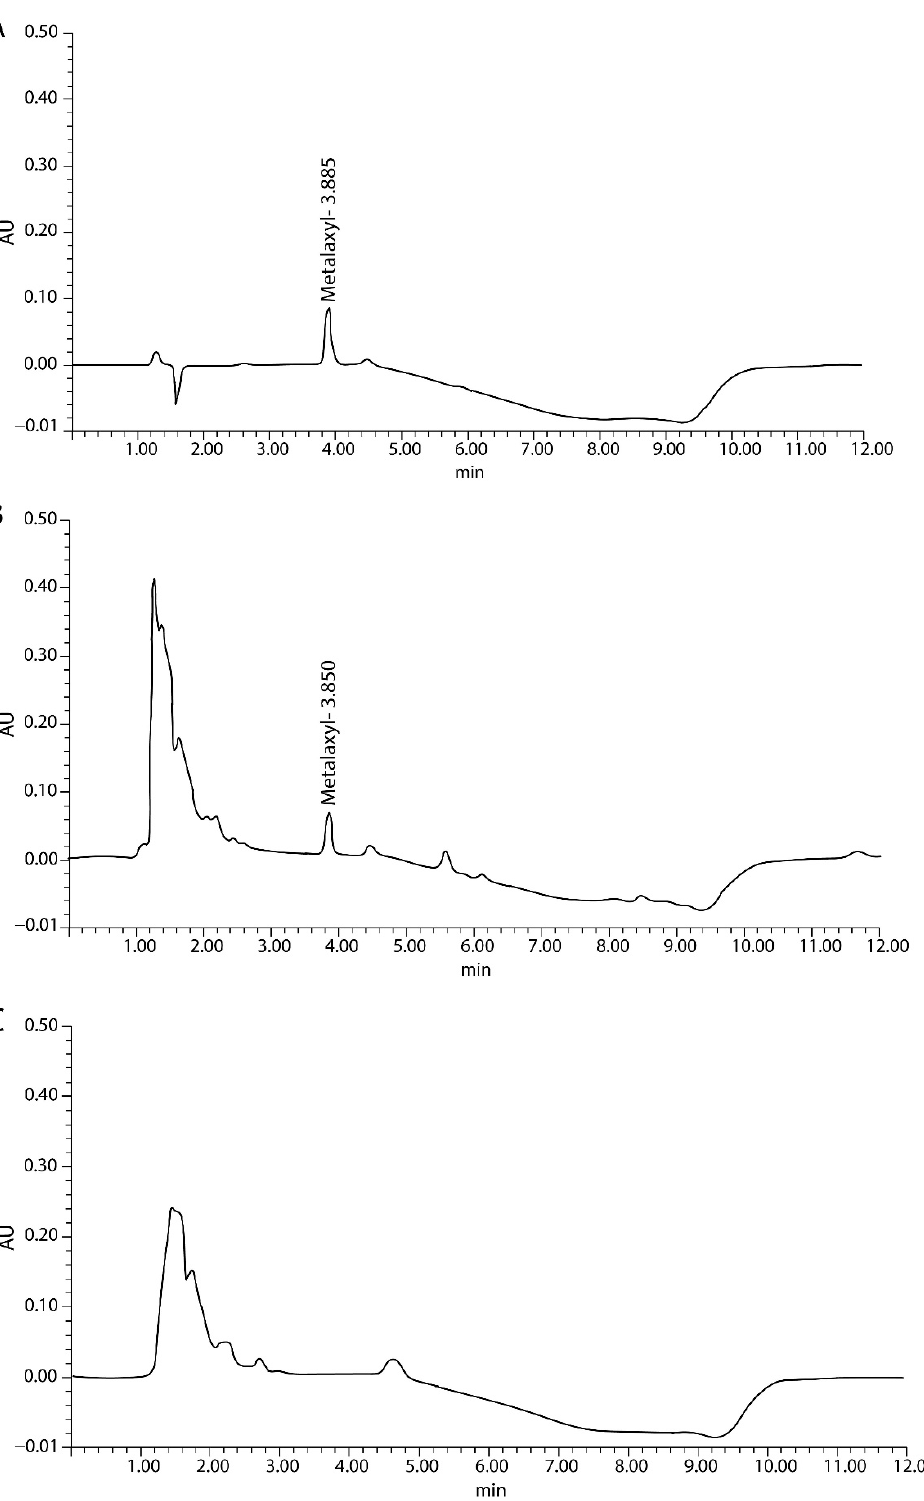
Figure 2. Chromatogram of 10 µg/mL metalaxyl standard, ( A ) 10 µg/mL spiked durian leaf sample, ( B ) and untreated durian leaf sample ( C ).